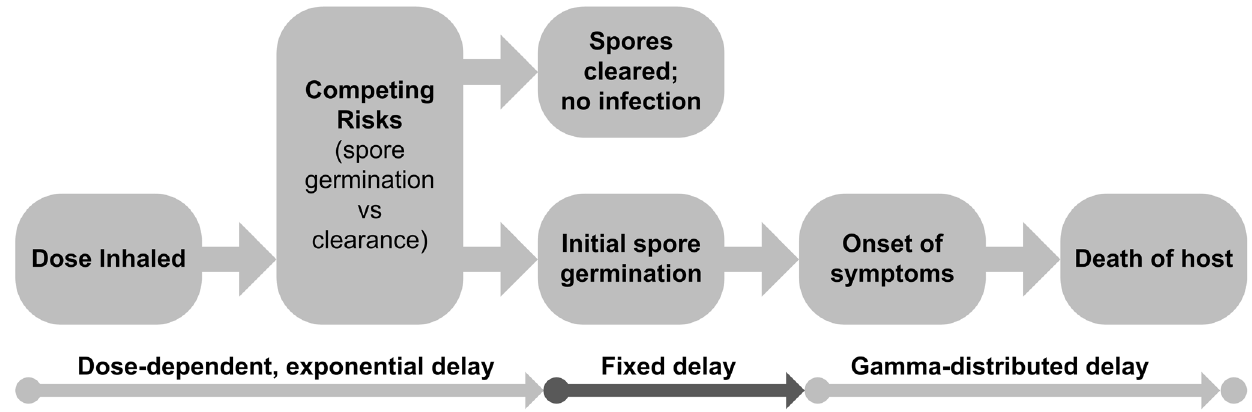
Figure 6. Schematic of the determination of infection and the infection timeline for anthrax. This depicts the assumptions made under the time-dose-response model B4 , developed for this paper. After a dose of a given size is inhaled, a competing risks process determines whether infection occurs and the distribution of the time between exposure and infection (initial spore germination) if it does occur. We assume a fixed delay between initial spore germination and the onset of symptoms and a gamma-distributed delay between the onset of symptoms and death among untreated cases.